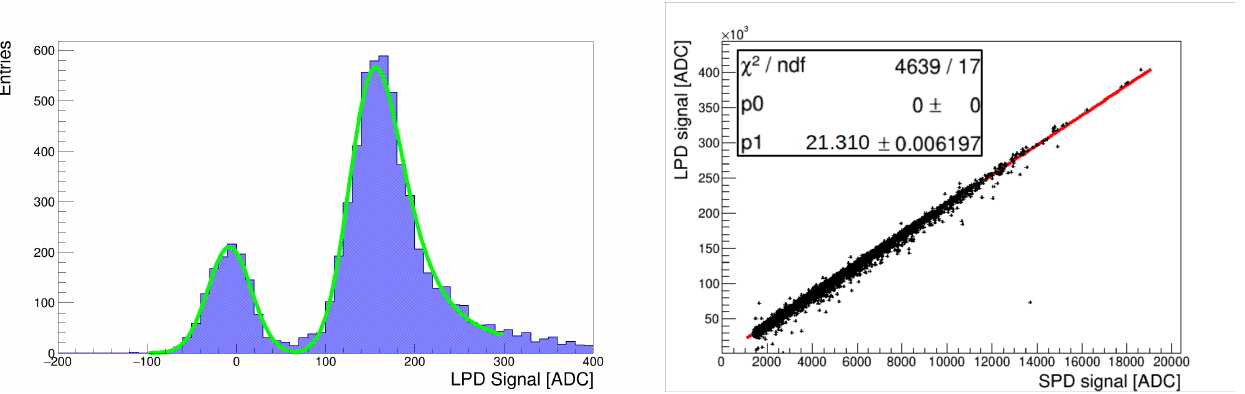
Figure 3. ( Left side): MIP distribution of an LPD. ( Right side): correlation plot between LPD and SPD signals for a crystal.